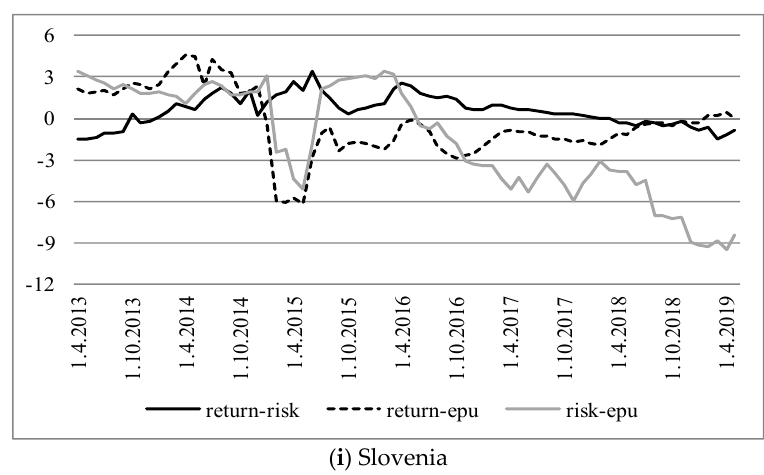
Figure A4. Rolling pair wise spillover indices for every country.